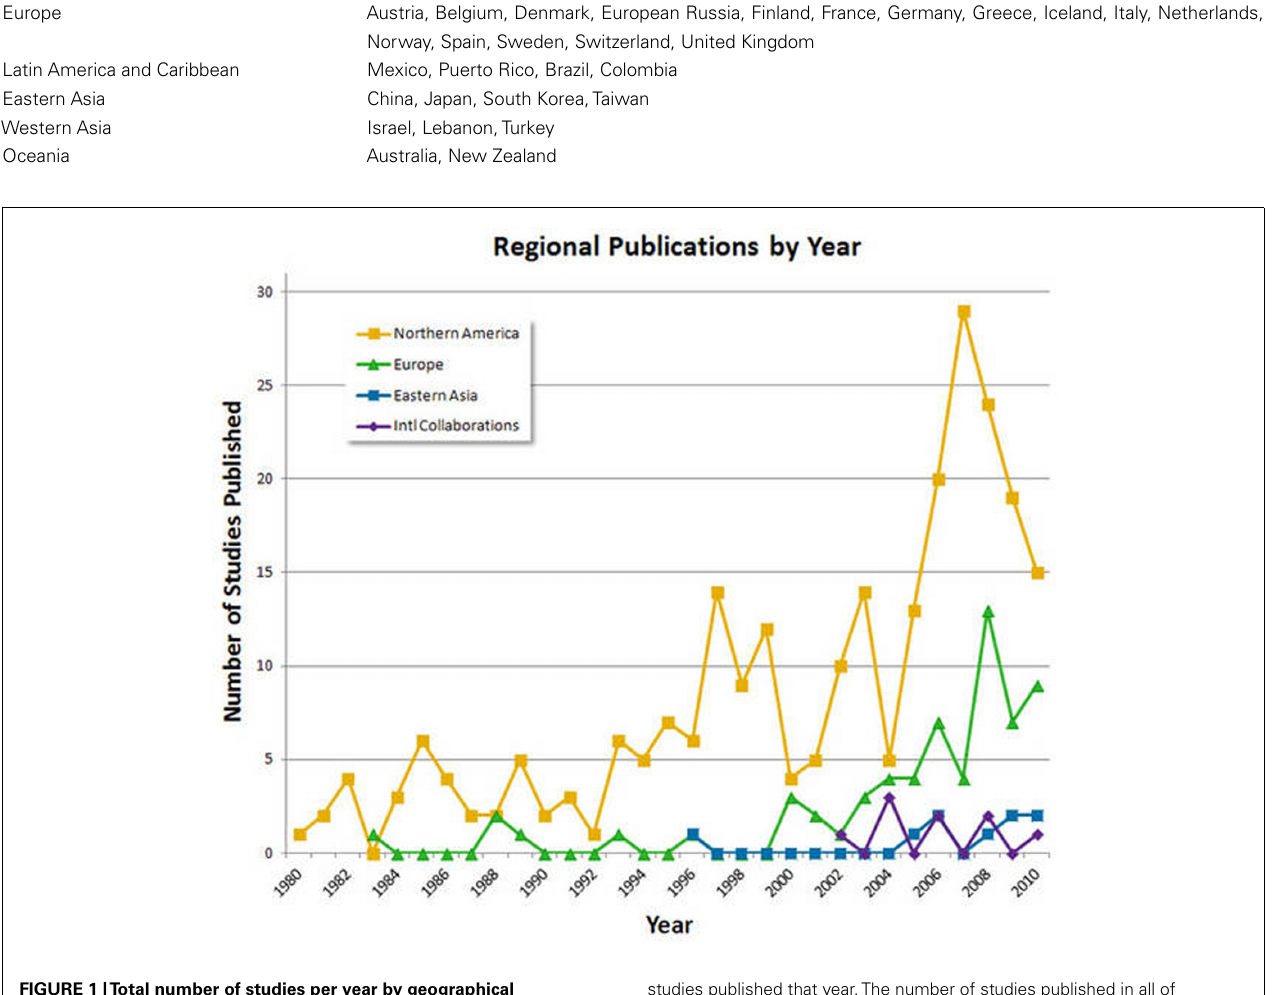
FIGURE 1 |Total number of studies per year by geographical region. There was a marked rise in studies of long-term outcomes of ADHD published worldwide between 1980 and 2010.The number of long-term outcome studies published globally peaked in 2008 with 42